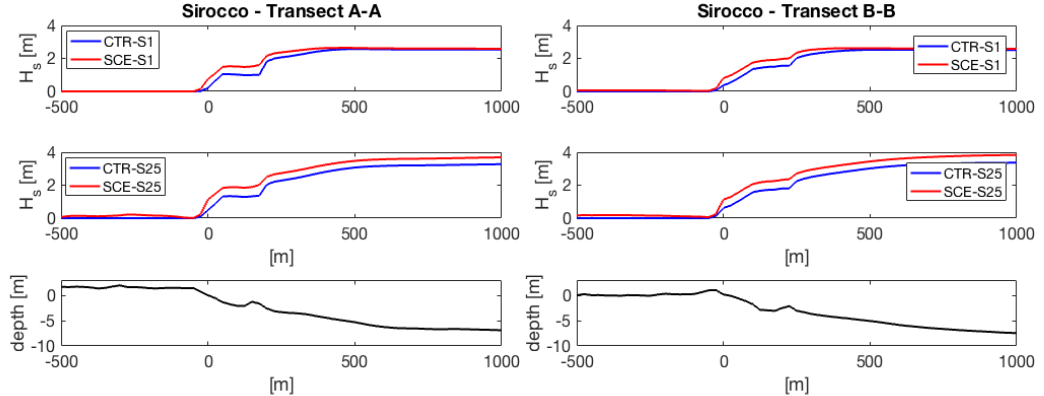
Figure 9. Sirocco events. Cross-shore distribution of the significant wave height H s as calculated by TOM along the transect A-A ( left panels ) and transect B-B ( right panels ).